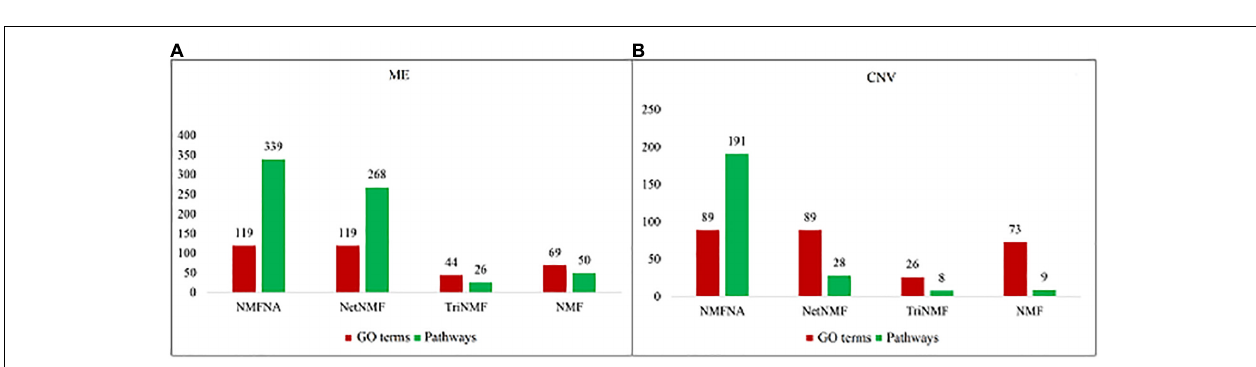
FIGURE 2 | Parameter settings for the NMFNA. (A) Is the influence of parameter and (B) is the convergence analysis of NMFNA.